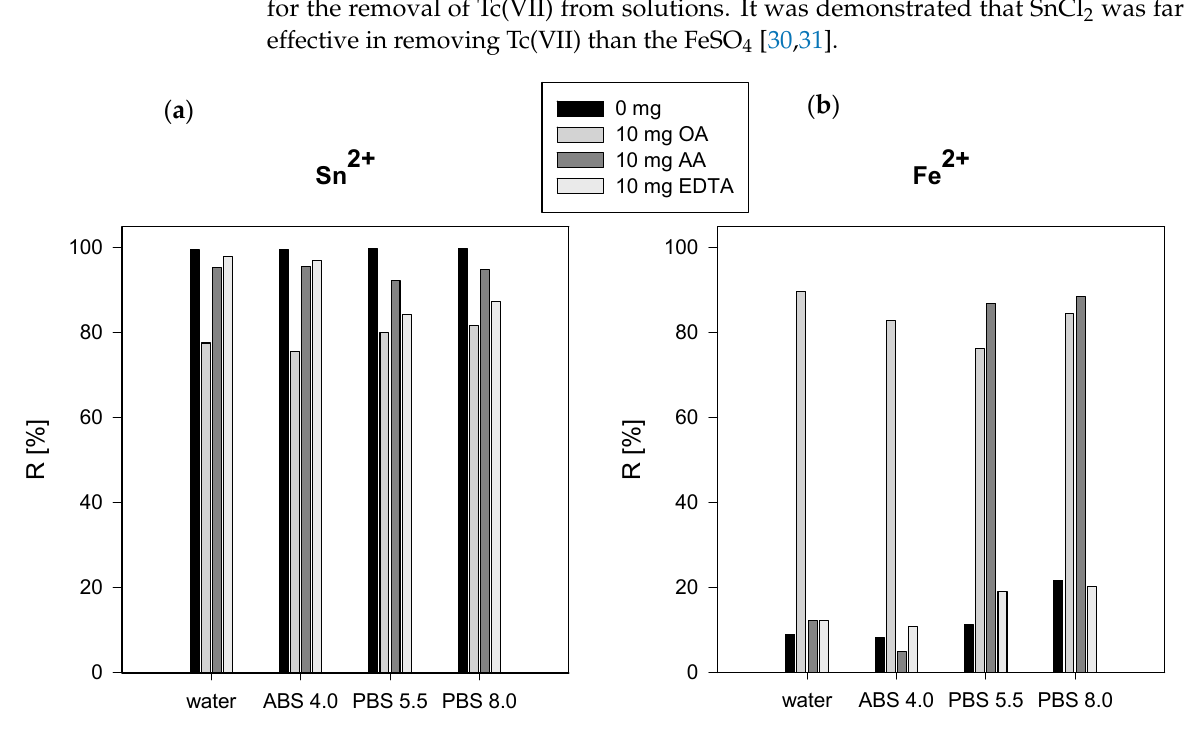
Figure 2. Percentage of 99m TcO 4 − sorption onto hydroxyapatite after reduction with SnCl 2 ( a ) and FeSO 4 ( b ) in the presence of complexing ligands.